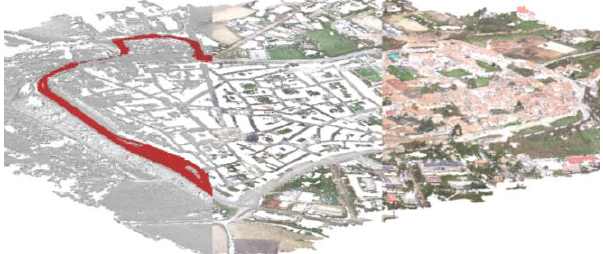
Figure 2. Urban scale cloud segmentation. From the left: DSM and DTM point cloud segmentation, road detection based on radiometric values.